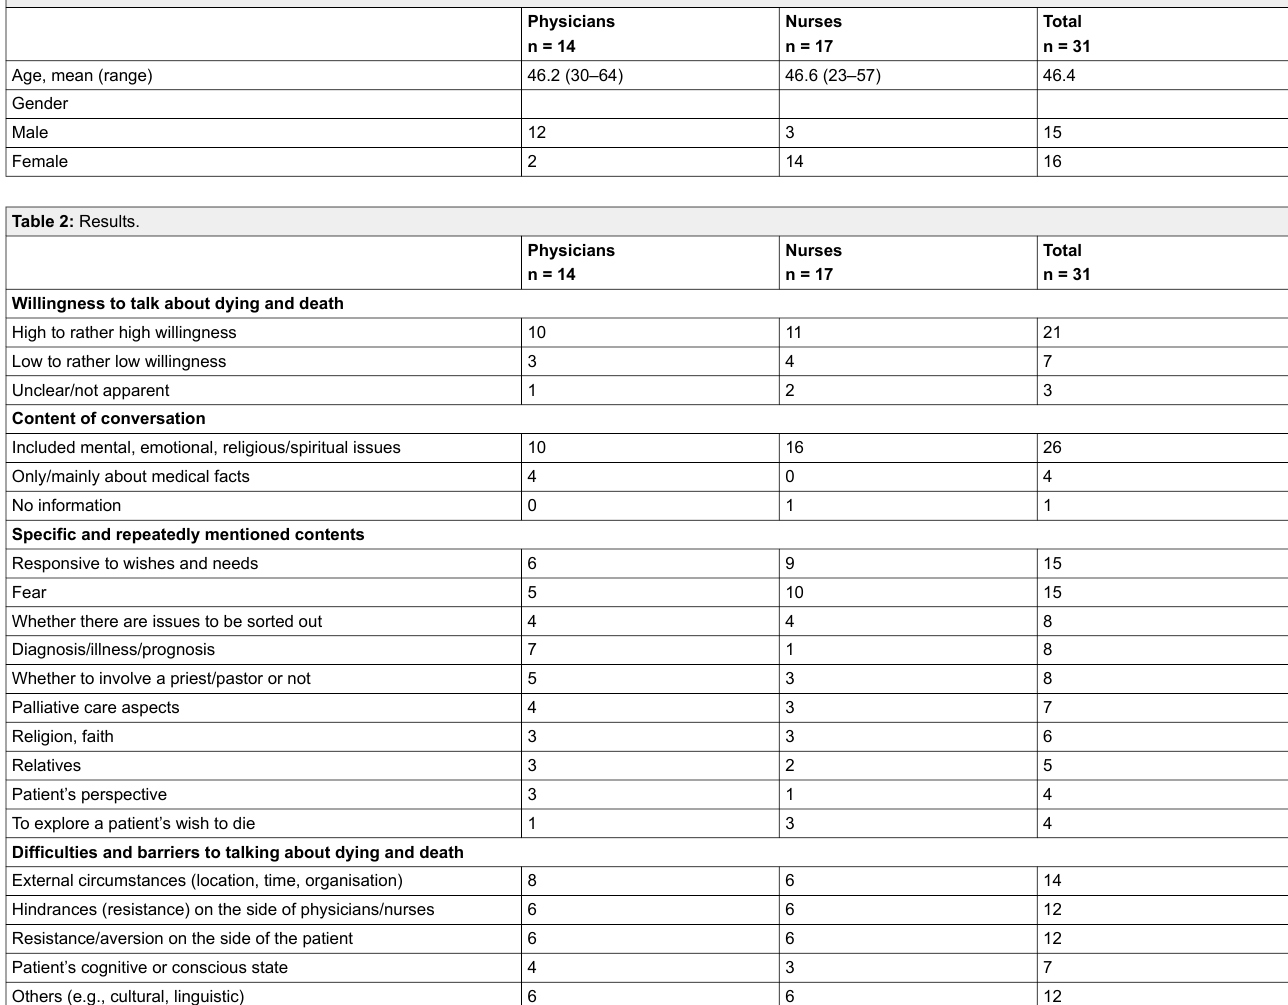
Table 1: Characteristics of the interviewees.